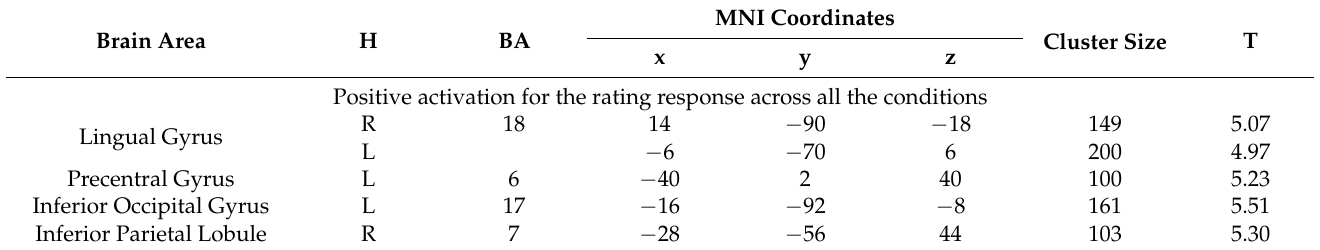
Table 2. Activated brain regions for rating